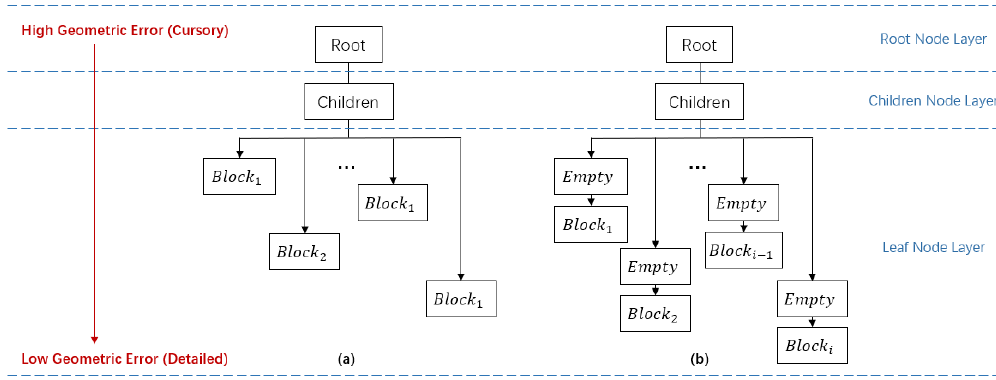
Figure 5. Structure of the index tree: ( a ) one-level index structure, and ( b ) “Mask Filter” index structure.